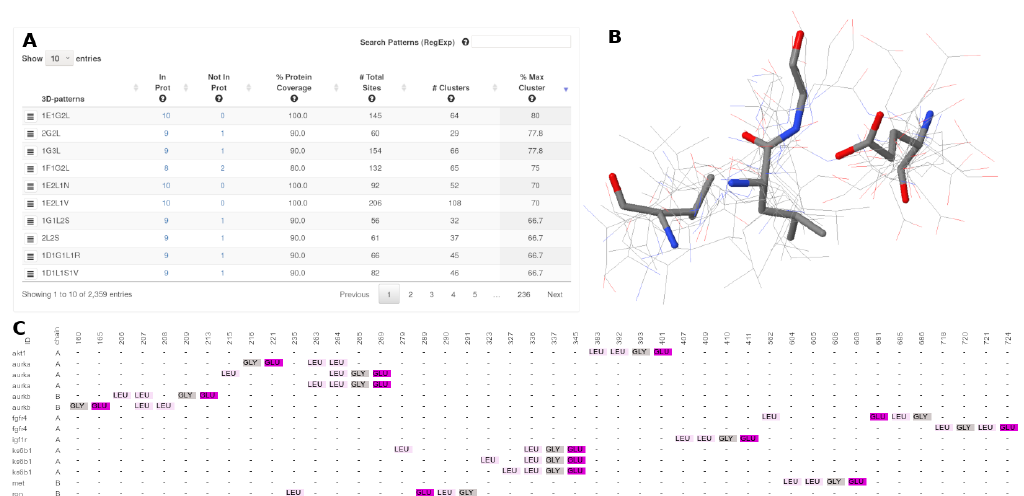
Figure 6. Coverage of 3D-patterns detected in the homology models of over expressed proteins in some cancer types. A shows the list of conserved 3D-patterns. B shows the structural alignment of the sites forming the 3D-pattern 1E1G2L. C shows a representation of a sequence alignment of the structurally aligned sites that form the 3D-pattern